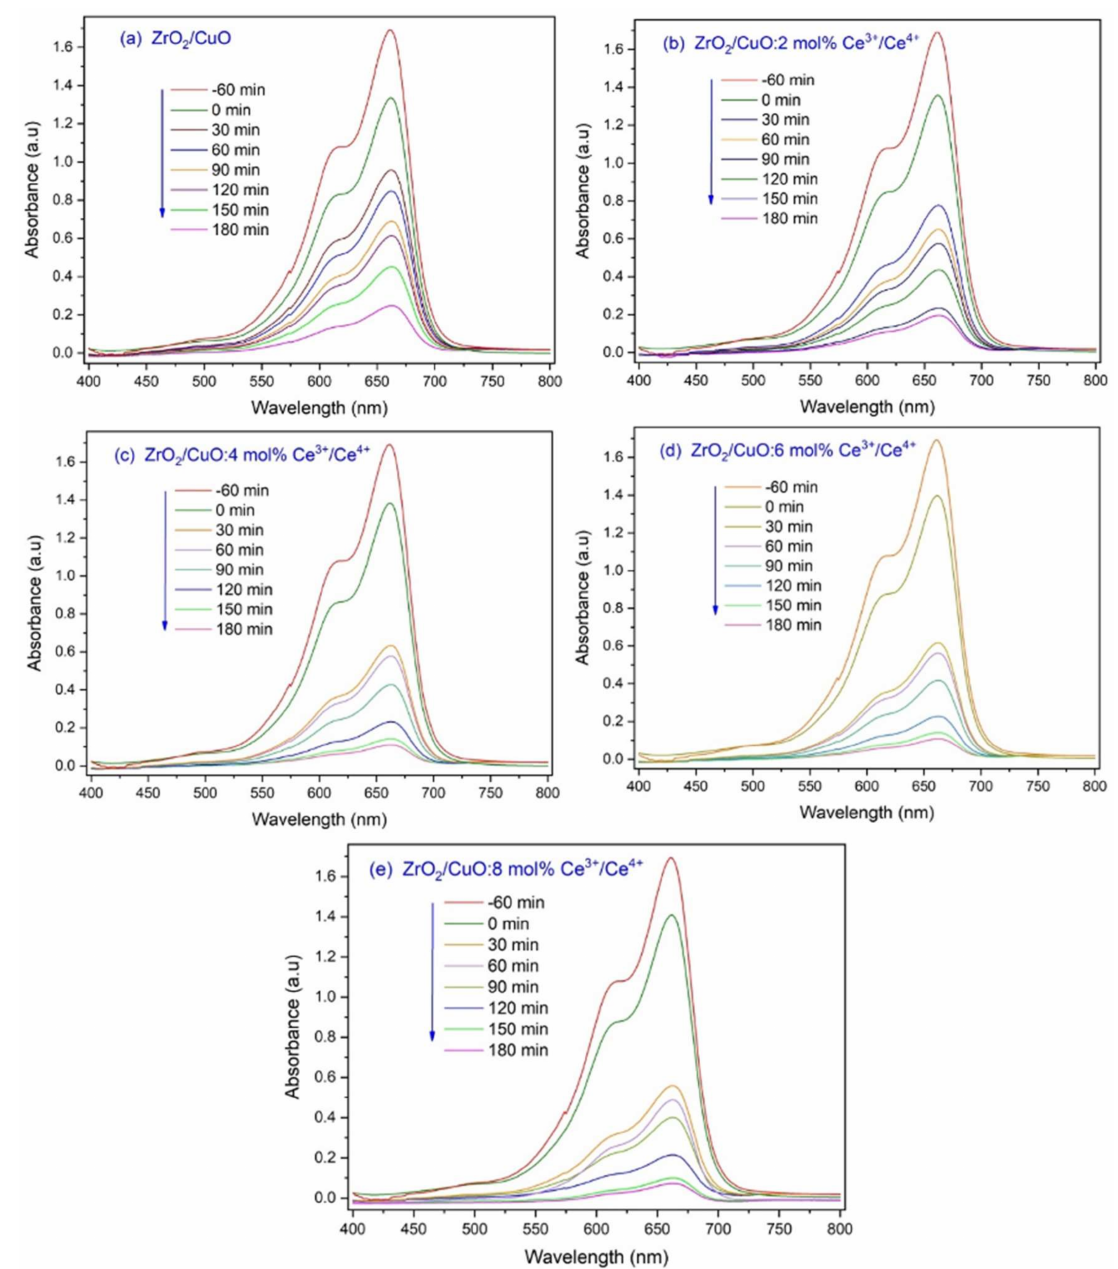
Figure 8. UV-Vis absorbance of MB under visible light at different times in the presence of x mol% Ce 3+ /Ce 4+ -doped ZrO 2 /CuO: ( a ) x = 0; ( b ) x = 2; ( c ) x = 4; ( d ) x = 6; ( e ) x =